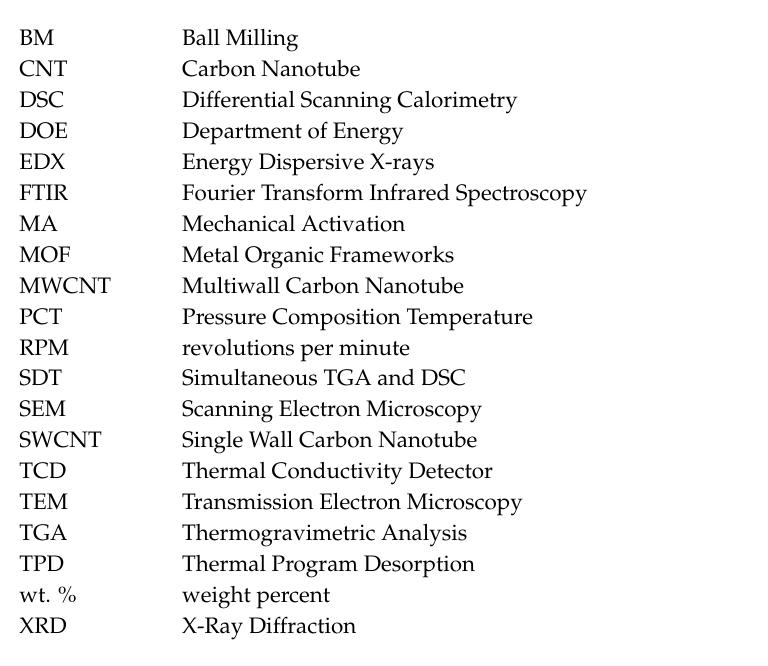
Figure S1: TGA analysis of Ni doped LiNH 2 -nanoMgH 2 (2:1); Figure S2: Absorption kinetics of 2LiNH 2 -nanoMgH 2 + 2 wt. % Ni at 180, 200 and 220 ◦